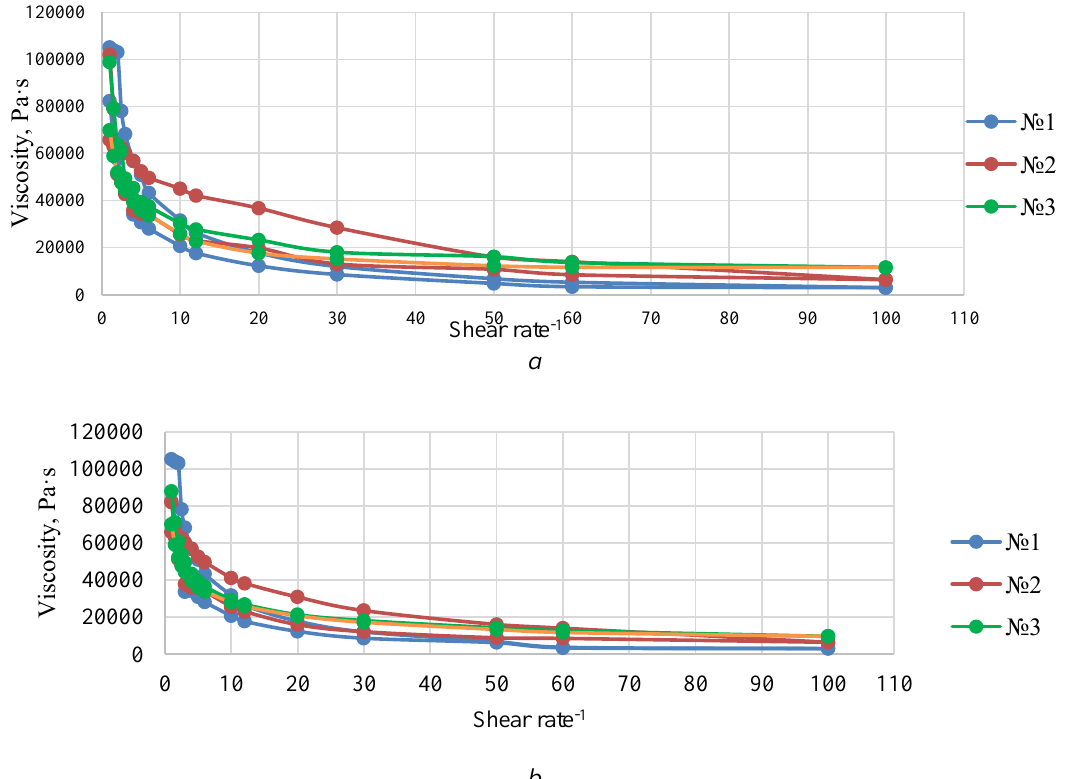
Fig. 3. Dependence of dynamic viscosity on shear stress in samples of drugs in soft dosage forms with nanoparticles of silver: a – after preparation; b – after 24 months of storage